Question: State the chart type depicted above.
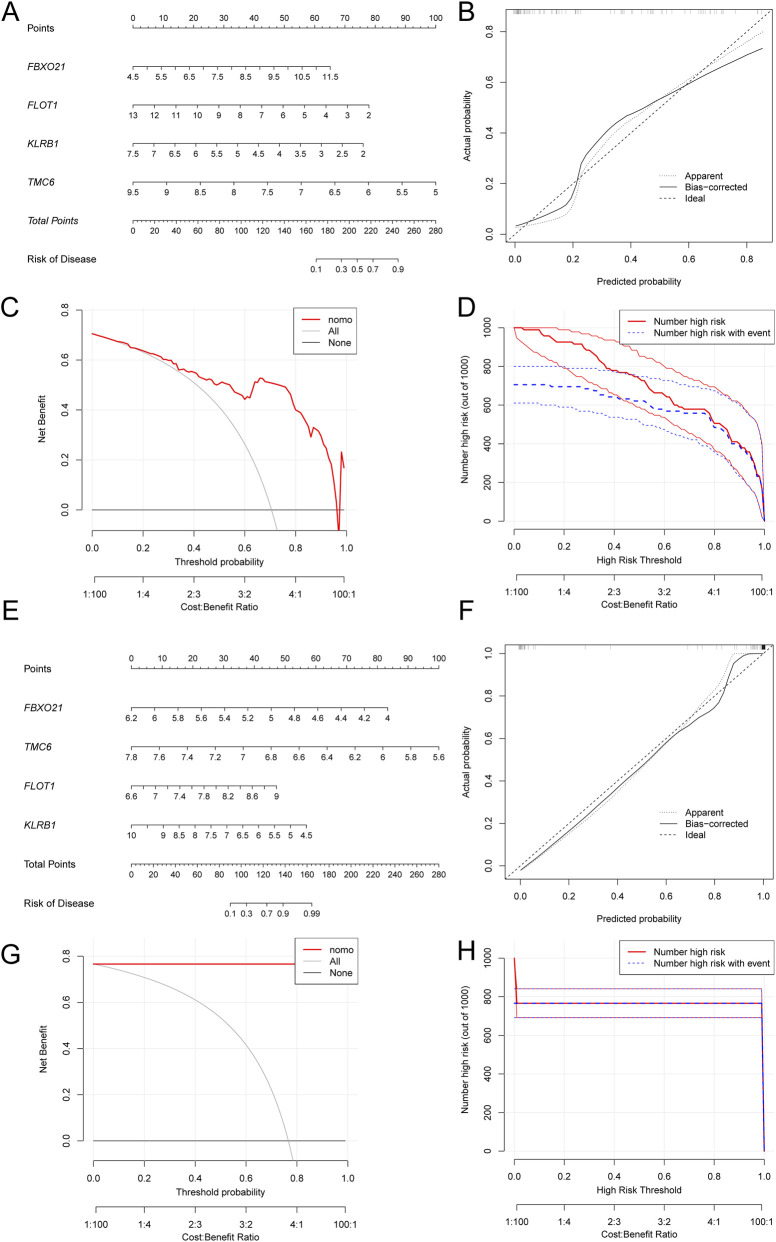
Answer: line